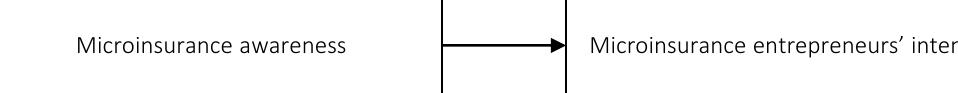
Figure 1. Model of the